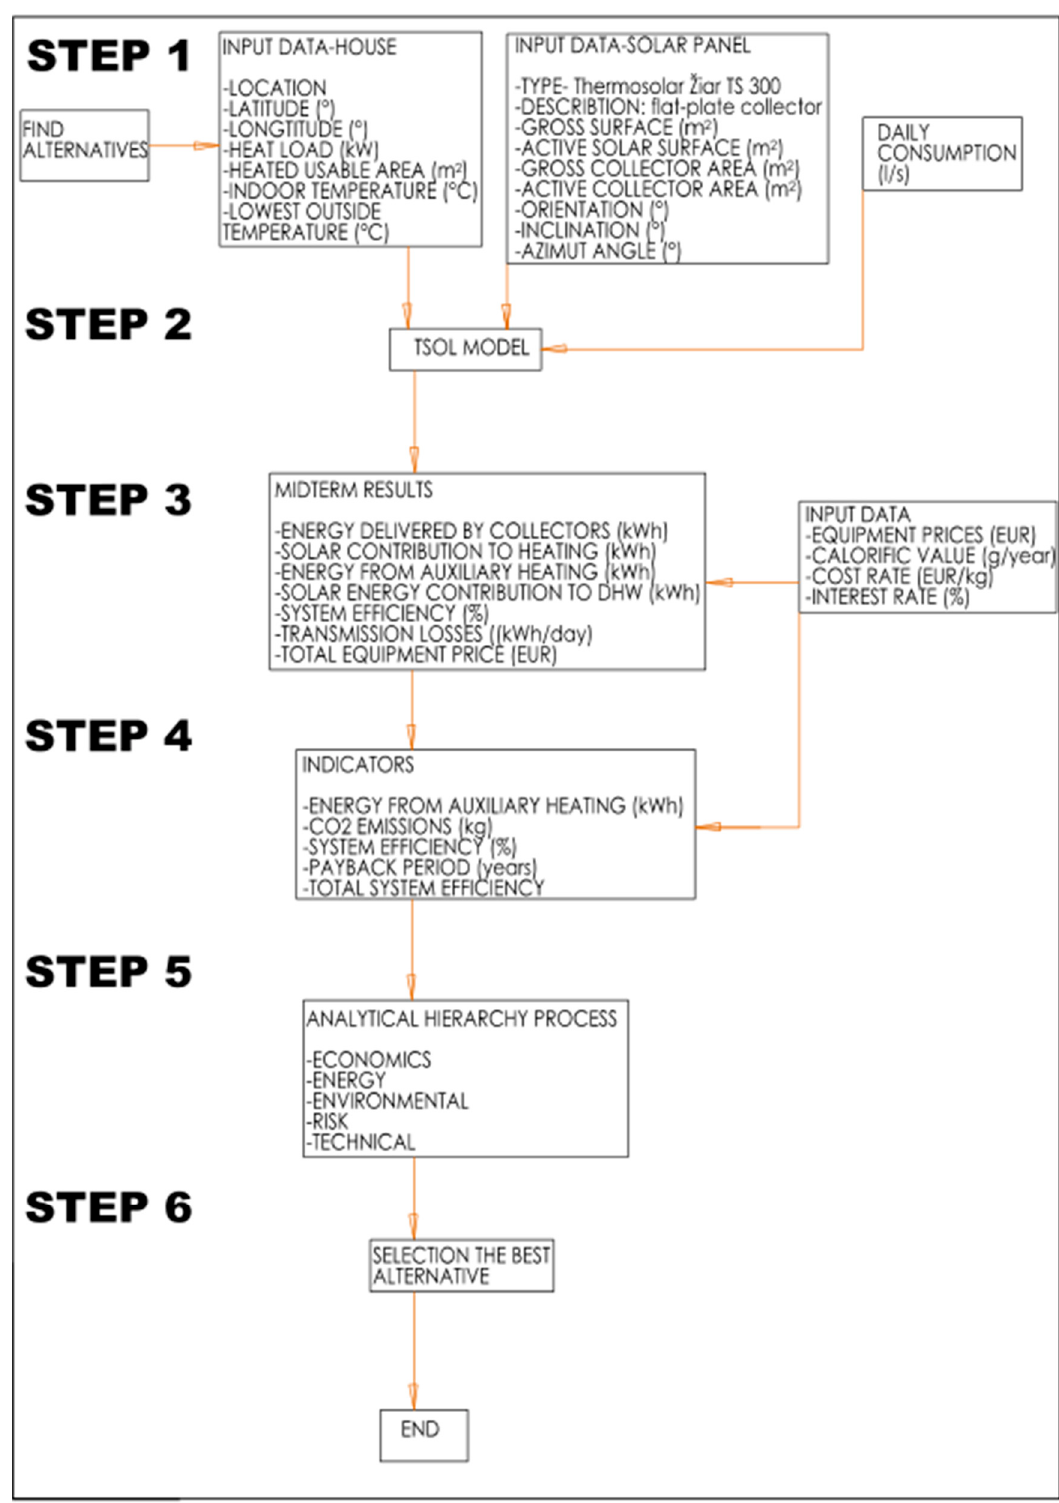
Figure 1. Flowchart. Figure 1.